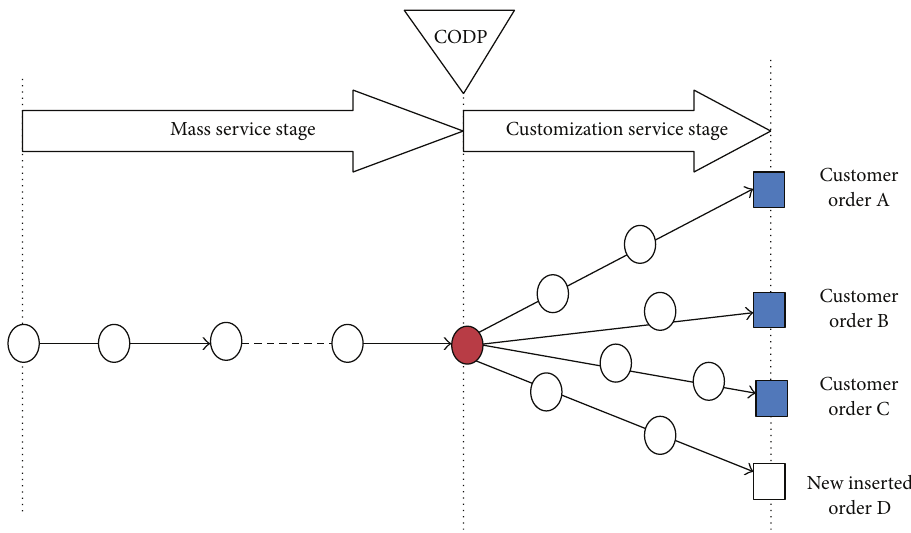
Figure 1: Customer orders’ operation processes schematic diagram of general